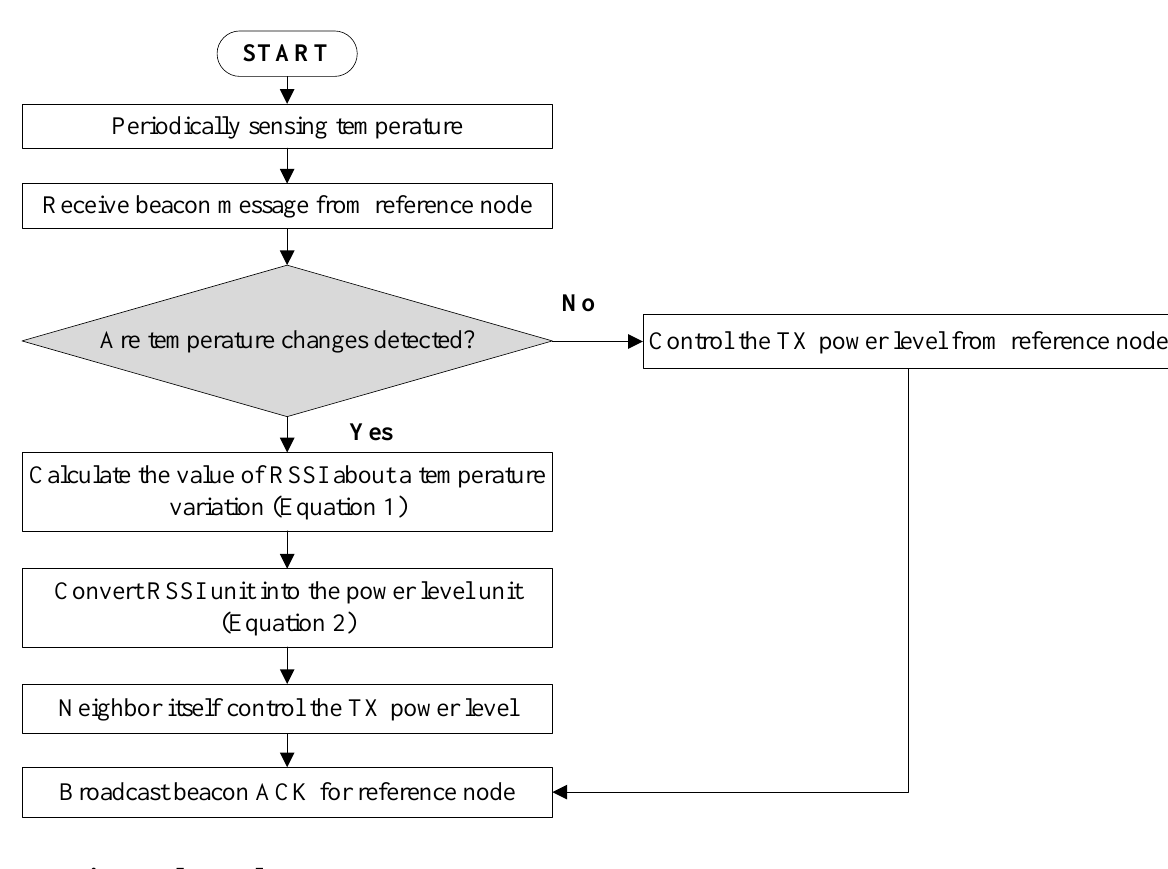
Figure 9. The flowchart of the neighbor